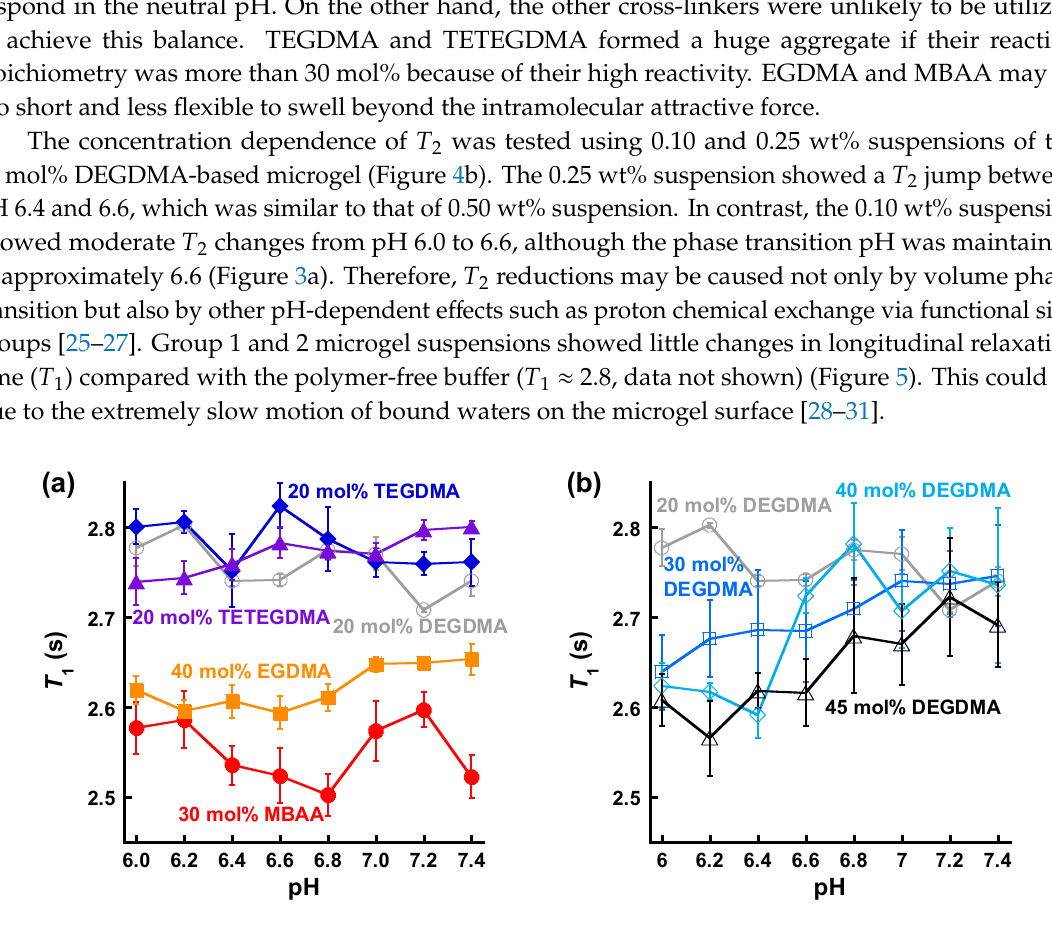
Figure 5. Longitudinal relaxation time ( T 1 ) of microgel suspensions of ( a ) Group 1 and ( b ) Group 2 in the pH range of 6.0–7.4 at 28 °C (mean ± SEM, n = 3). The microgel cross-linked with 20 mol% DEGDMA is shown in both figures. [microgel] = 0.50 wt%.